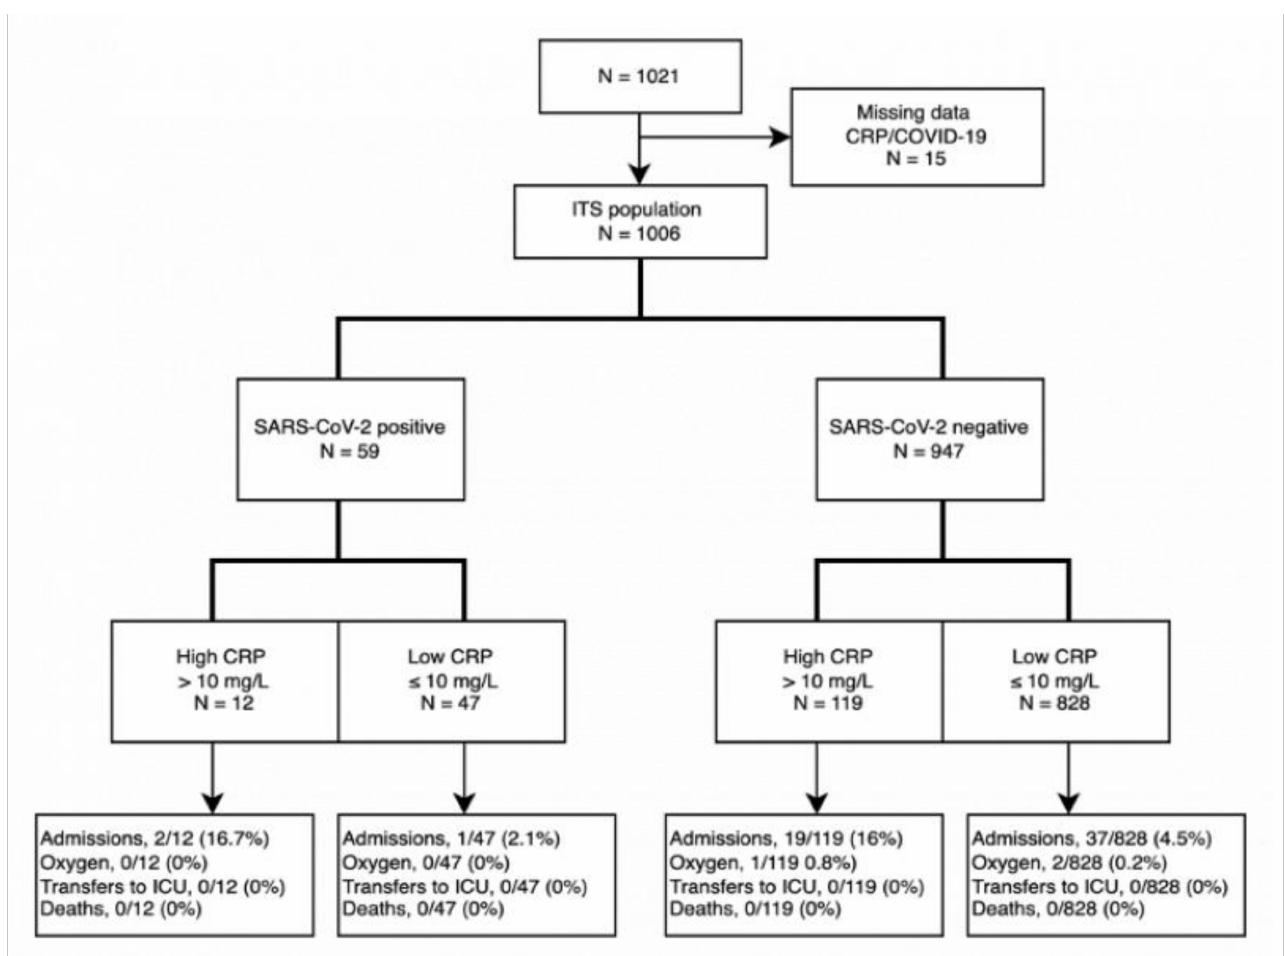
Figure 1. Flow of participants through each stage of the prospective cohort